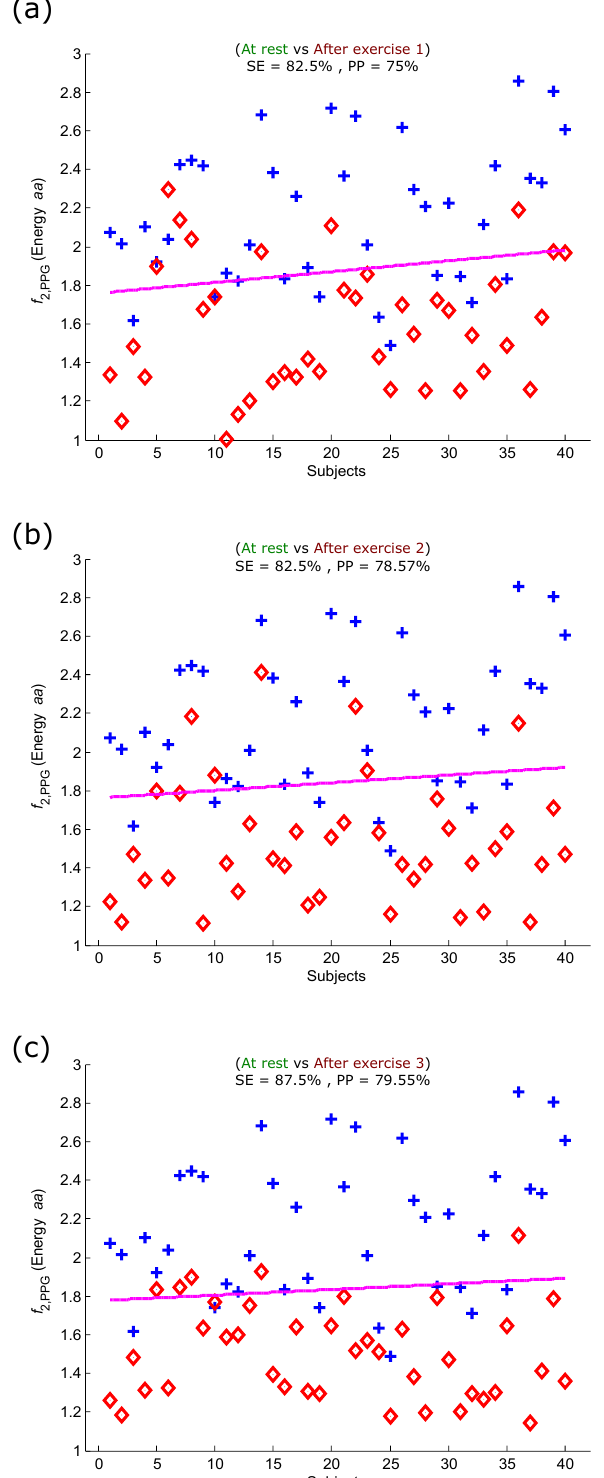
Figure 6. Linear classification of PPG signals measured before and after the simulated heat stress induction based on the energy of the aa area of the PPG signal. ( a ) At rest vs. after exercise 1; ( b ) at rest vs. after exercise 2; ( c ) at rest vs. after exercise 3. Here, SE stands for sensitivity and PP stands for positive predictivity. The plus signs refer to subjects measured at rest, while the diamond signs refer to subjects measured after the simulated heat stress